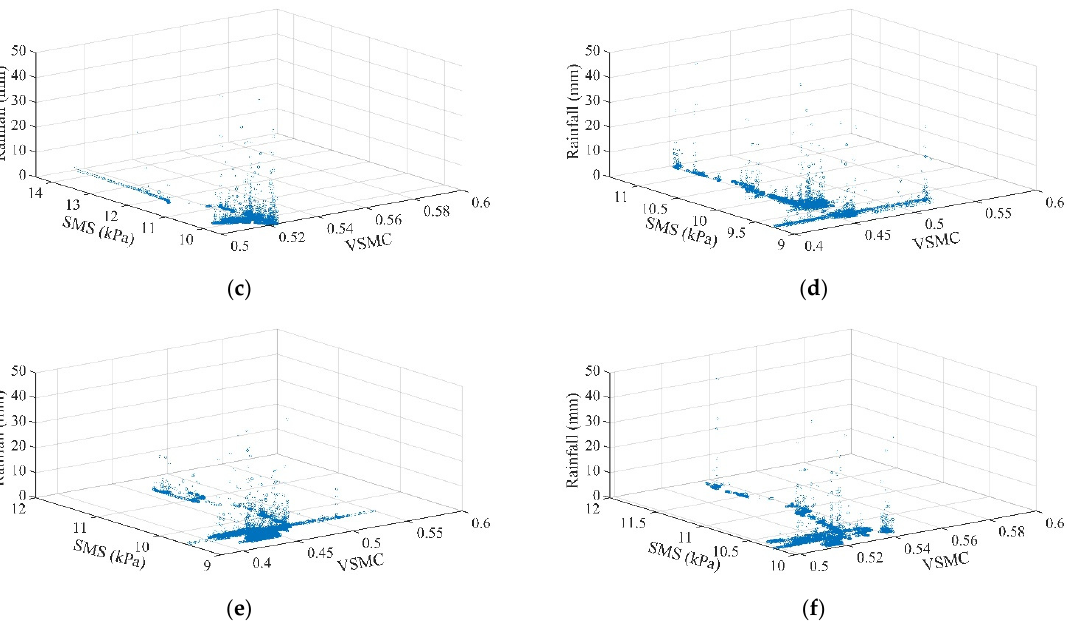
Figure A1. 3D in situ variation of rainfall, SMS, and VSMC at 3 m depth ( a ) HWS 1 ( b ) HWS 2 ( c ) HWS 3 ( d ) HWS 4 ( e ) HWS 5 ( f ) HWS 6.